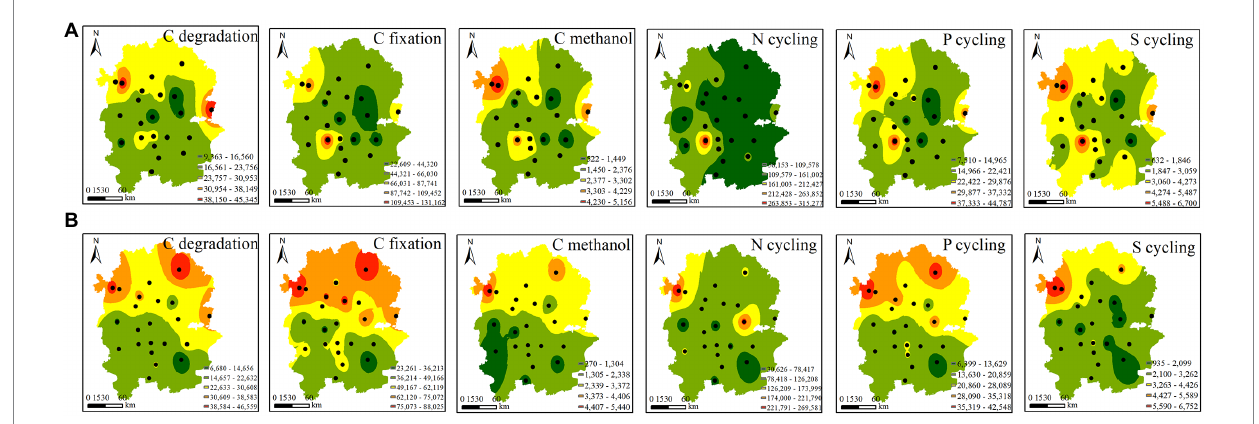
FIGURE 3 Spatial distribution of the abundances of the functional genes involved in CNPS cycles in A . palmeri (A) and native (B) rhizosphere soils. Black dots indicate the sampling sites.